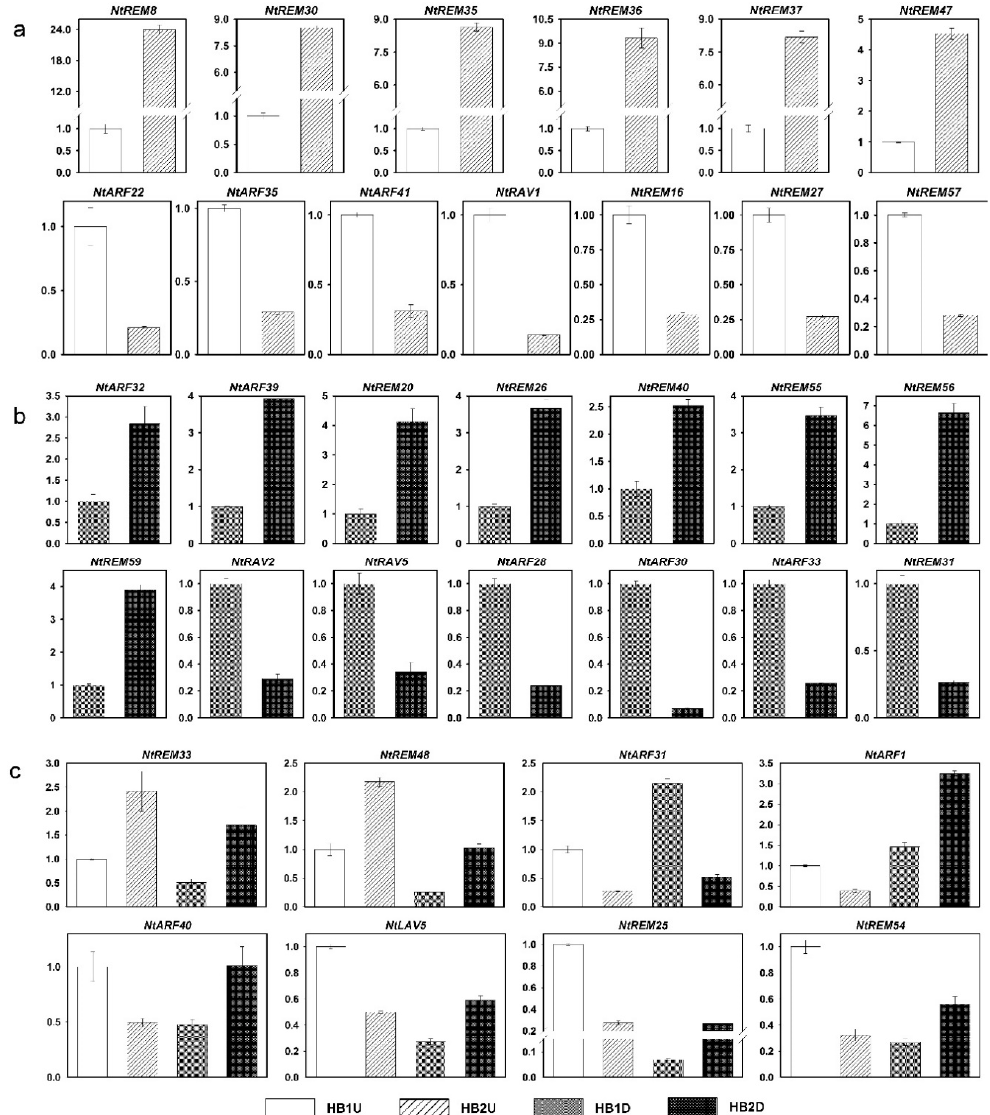
Figure 9. qRT-PCR analysis of the B3 genes in response to topping with at least 2.5-fold range. ( a ) The expression level of the B3 genes changed only in upper axillary buds after topping. ( b ) The expression level of the B3 genes changed only in lower axillary buds after topping. ( c ) The expression level of the B3 genes changed both in upper and lower axillary buds after topping.